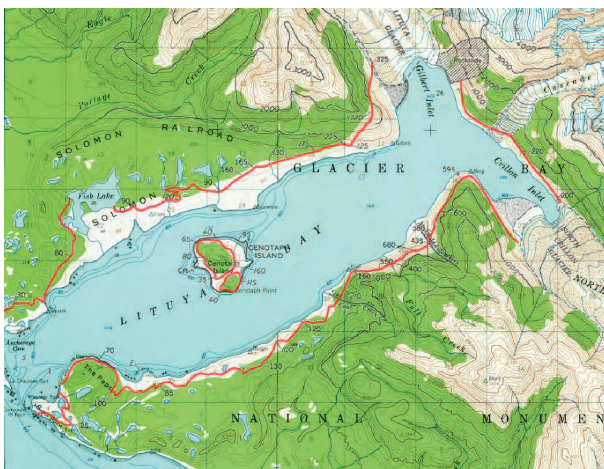
Figure 1. Topographic map of Lituya Bay (US Geologic Survey, 1961) showing the settings and trimline of the 1958 mega-tsunami (based on data from Miller, 1960). Units in feet. Key locations such as Gilbert and Crillon inlets, Cenotaph Island, Fish Lake, or The Paps are